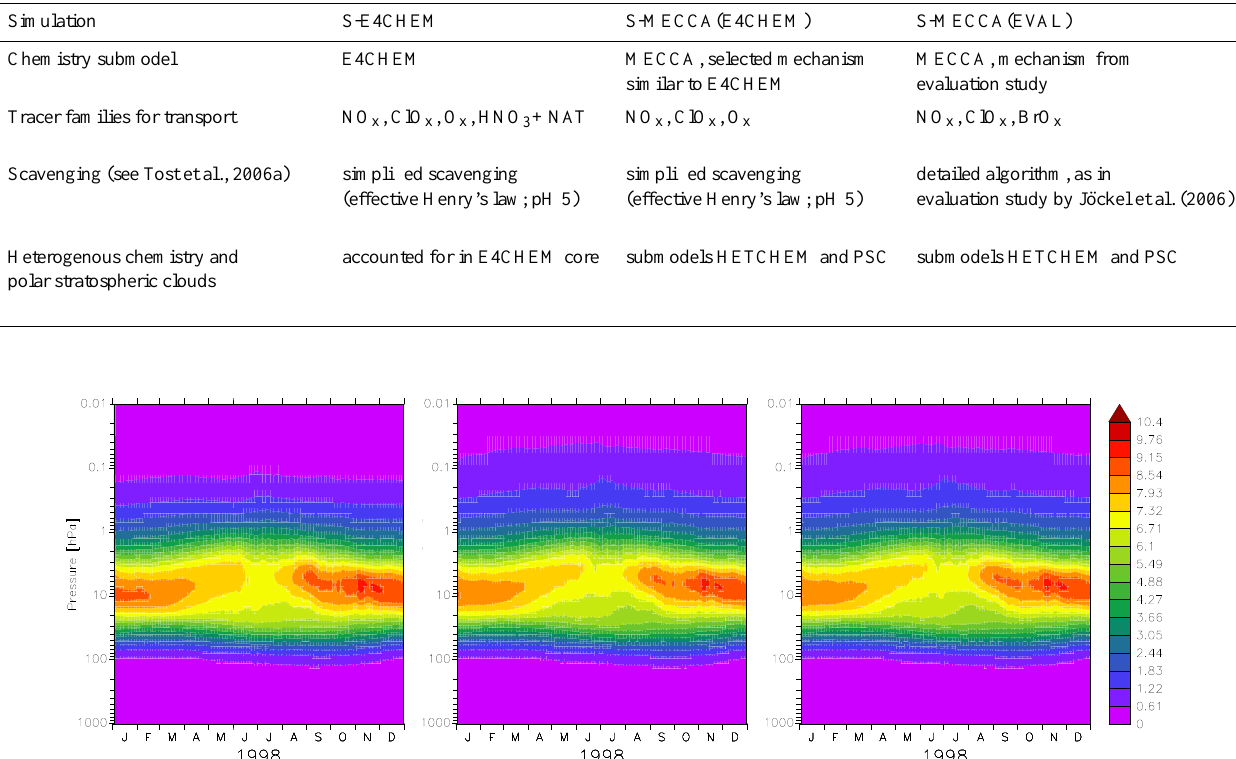
Table 1. Overview of the performed EMAC simulations.